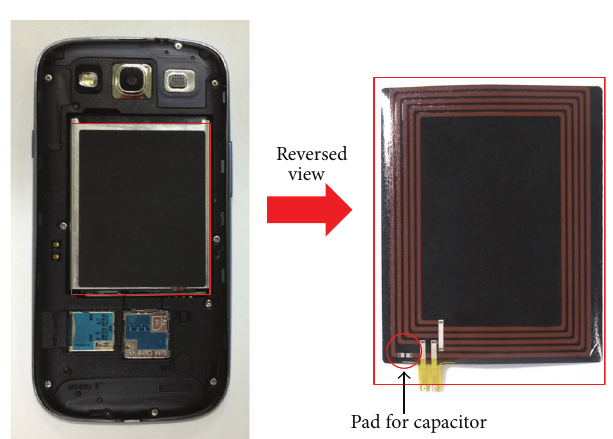
Figure 7: Prototype NFC antenna mounted on a mobile handset.